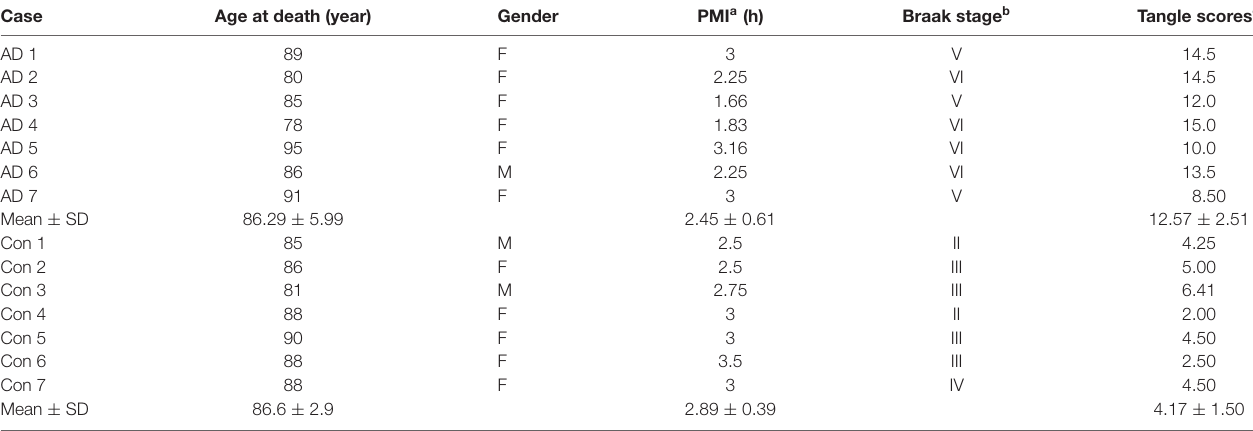
TABLE 1 | Alzheimer’s disease (AD) and control (Con) cases used in this study.